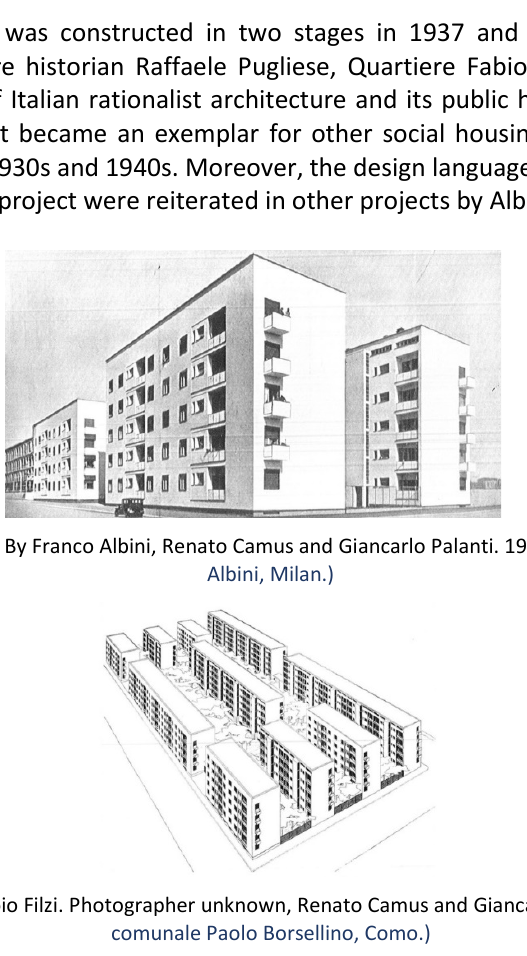
Figure 9 Quartiere Fabzio Filzi. Photographer unknown, Renato Camus and Giancarlo Palanti. 1939. (Biblioteca comunale Paolo Borsellino, Como.)